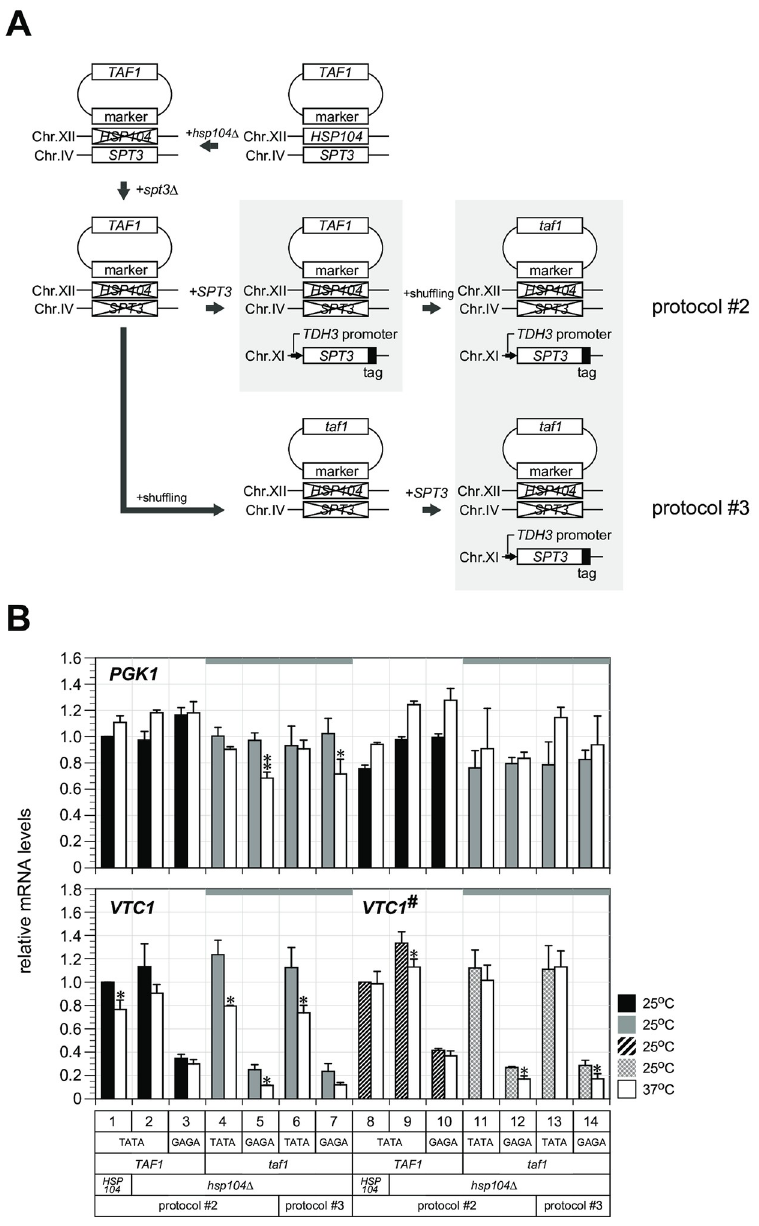
Fig 3. Effect of the hsp104 Δ mutation on Taf1/TFIID dependence of the PGK1 promoter via protocol #3. (A) Schematic outline of strain construction protocols #2 and #3 in strains harboring the hsp104 Δ mutation. These protocols were the same as described in S1A Fig, except that the starting strain carried the hsp104 Δ mutation. (B) RT- qPCR analysis to measure PGK1 mRNA levels (top panel) or VTC1/VTC1 # mRNA levels (bottom panel) in the 14 haploid strains carrying VTC1 (lanes 1–7) or the VTC1 # reporter (lanes 8–14) driven by the PGK1 promoter in which the TATA box was intact (lanes 1, 2, 4, 6, 8, 9, 11, and 13) or substituted with the GAGA sequence (lanes 3, 5, 7, 10, 12, and 14), as indicated below the bottom panel. These strains were generated by protocol #2 (lanes 1–5 and 8–12) or #3 (lanes 6–7 and 13–14), respectively, as indicated below the bottom panel and as described in A . The strains used were YTK19317 (lane 1), YTK20037 (lane 2), YTK20039 (lane 3), YTK20038 (lane 4), YTK20040 (lane 5), YTK20049 (lane 6), YTK20050 (lane 7), YTK19663 (lane 8), YTK20041 (lane 9), YTK20043 (lane 10), YTK20042 (lane 11), YTK20044 (lane 12), YTK20051 (lane 13), and YTK20052 (lane 14).